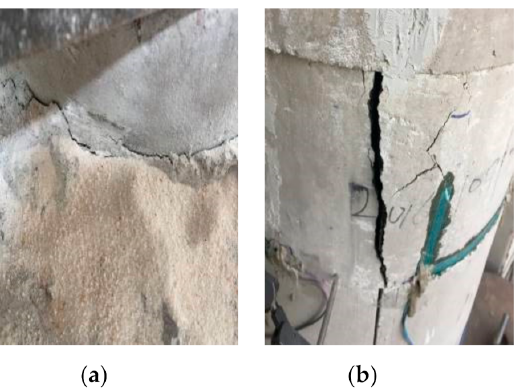
Figure 8. Failure of ordinary strengthened specimen. ( a ) Interface cracks; ( b ) LCSS